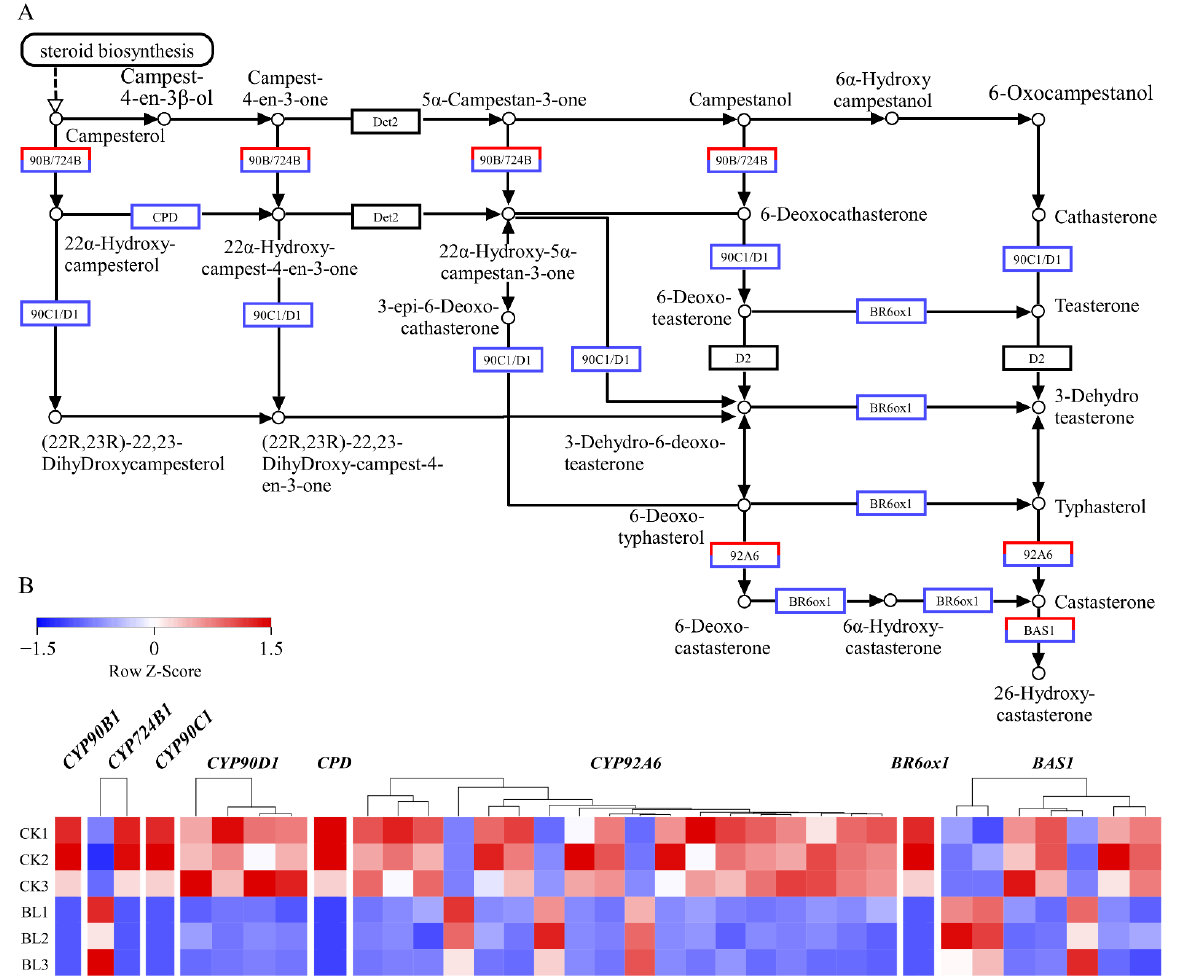
Figure 7. DEGs downregulated in the BR biosynthesis pathway were in the majority in the BL treatment. ( A ) The BR biosynthesis pathway (https://www.kegg.jp/entry/map00905 (accessed on 24 April 2022)). ( B ) Expression heat maps of the DEGs in CYP90B1, CYP724B1, CYP90C1, CYP90D1 , CPD , CYP92A6 , BR6ox1, and BAS1 in the six samples, respectively.